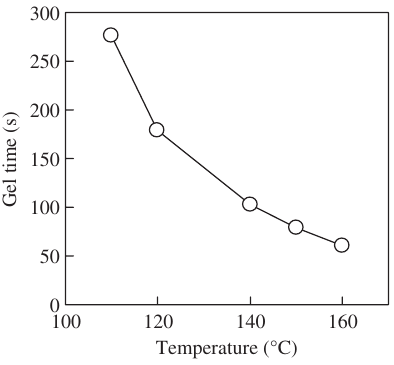
Figure 3 Relation of gel time to